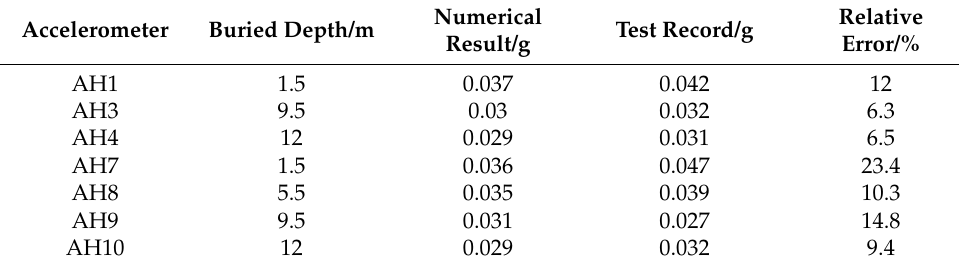
Table 4. The comparison of peak acceleration for simulation and experimental results.